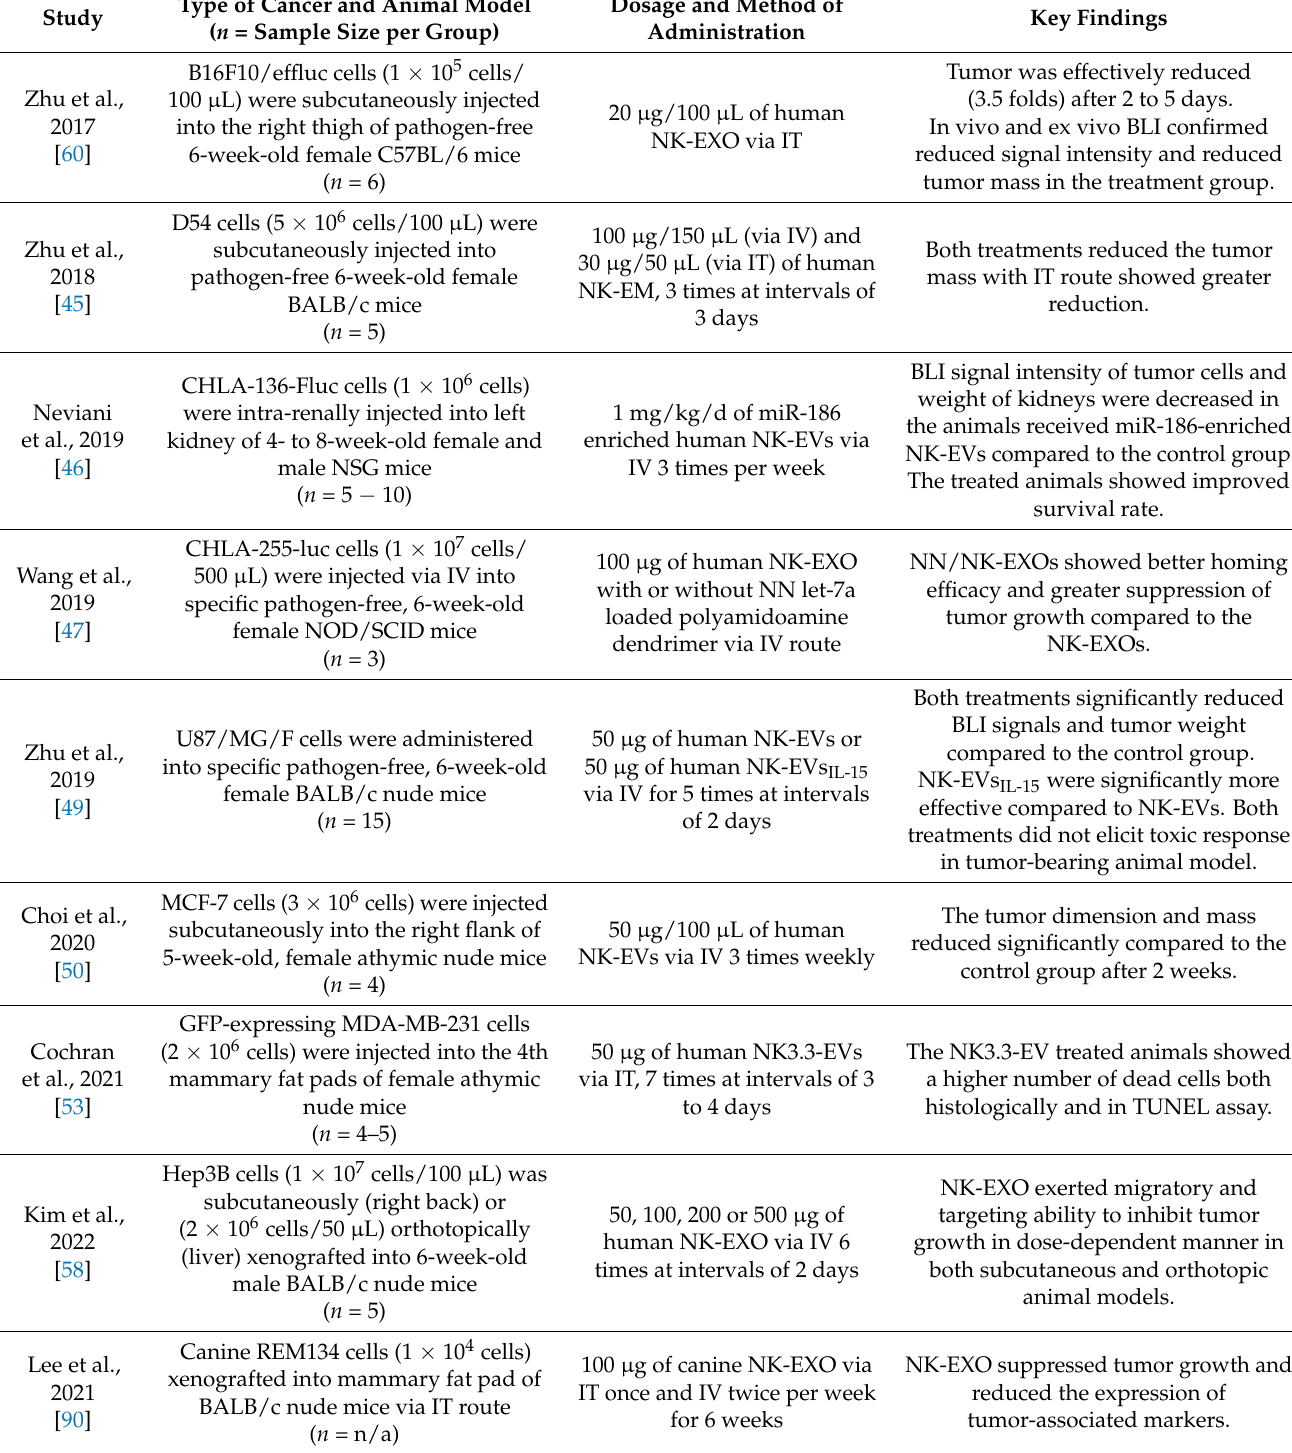
Table 2. In vivo evidence demonstrating the antitumor potential of